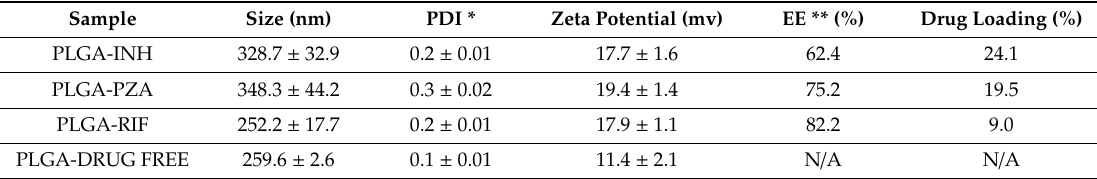
Table 1. Physical characteristics of nanoparticles prepared by the modified double emulsion solvent evaporation spray-drying